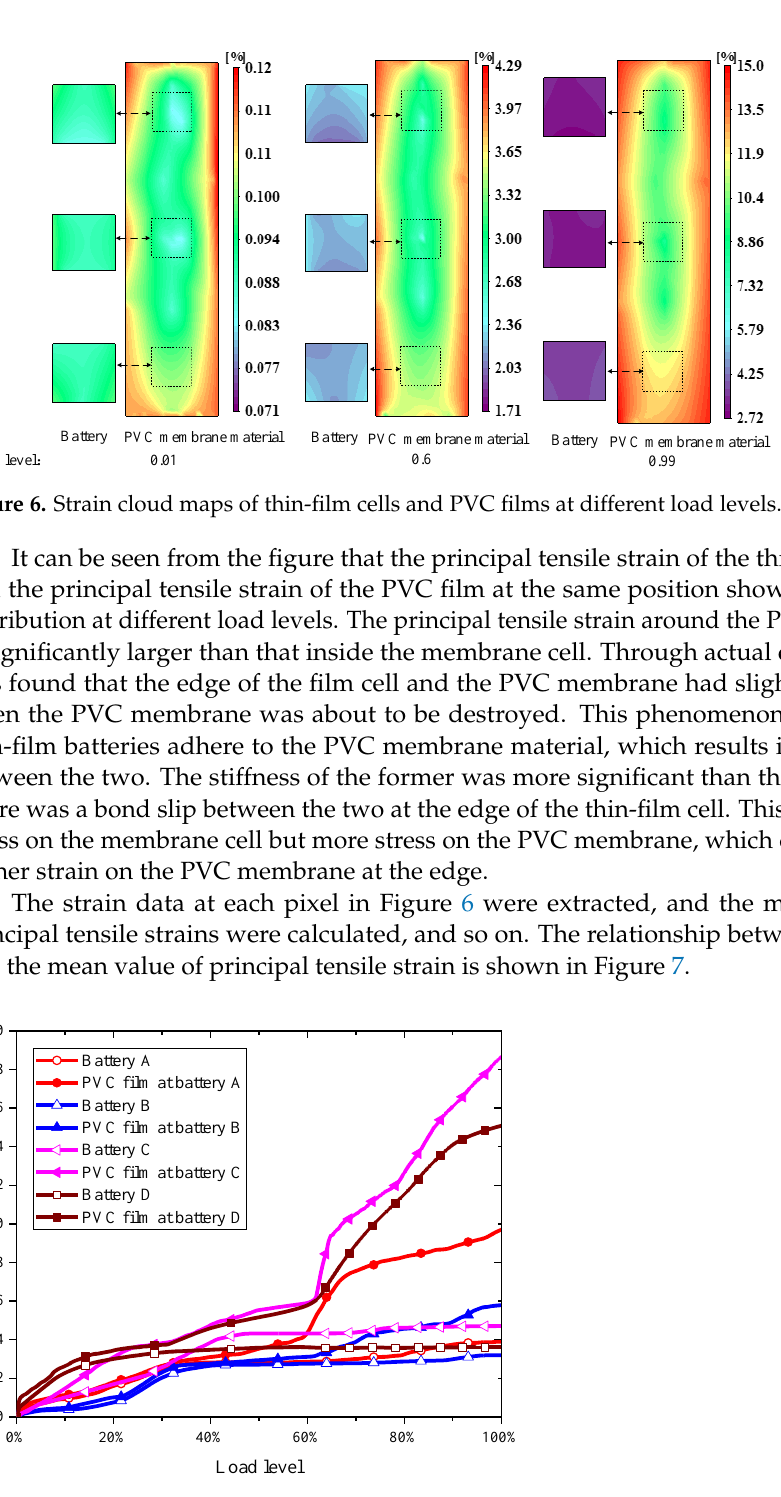
8 of 14 Figure 5. Experimental results of PVC membrane under uniaxial tension: ( a ) fiber direction ten- sion, ( b ) tensile force 45 degrees from fiber direction. 3.2. Deformation of Membrane and Battery Through the experiment in Figure 3, the corresponding limit loads in Figure 2a,b were 10.52 and 14.61 kN, respectively. The ratio of actual load to ultimate load is defined as the load level. The PVC membrane material at the thin-film battery B and the thin- film battery in Figure 2 is selected for analysis. Strain clouds at different load levels are shown in Figure 6. The general trend of strain clouds for the remaining batteries is simi- lar and will not be repeated here. It can be seen from the figure that the principal tensile strain of the thin-film battery and the principal tensile strain of the PVC film at the same position show non-uniform distribution at different load levels. The principal tensile strain around the PVC mem- brane is significantly larger than that inside the membrane cell. Through actual observa- tion, it was found that the edge of the film cell and the PVC membrane had slightly